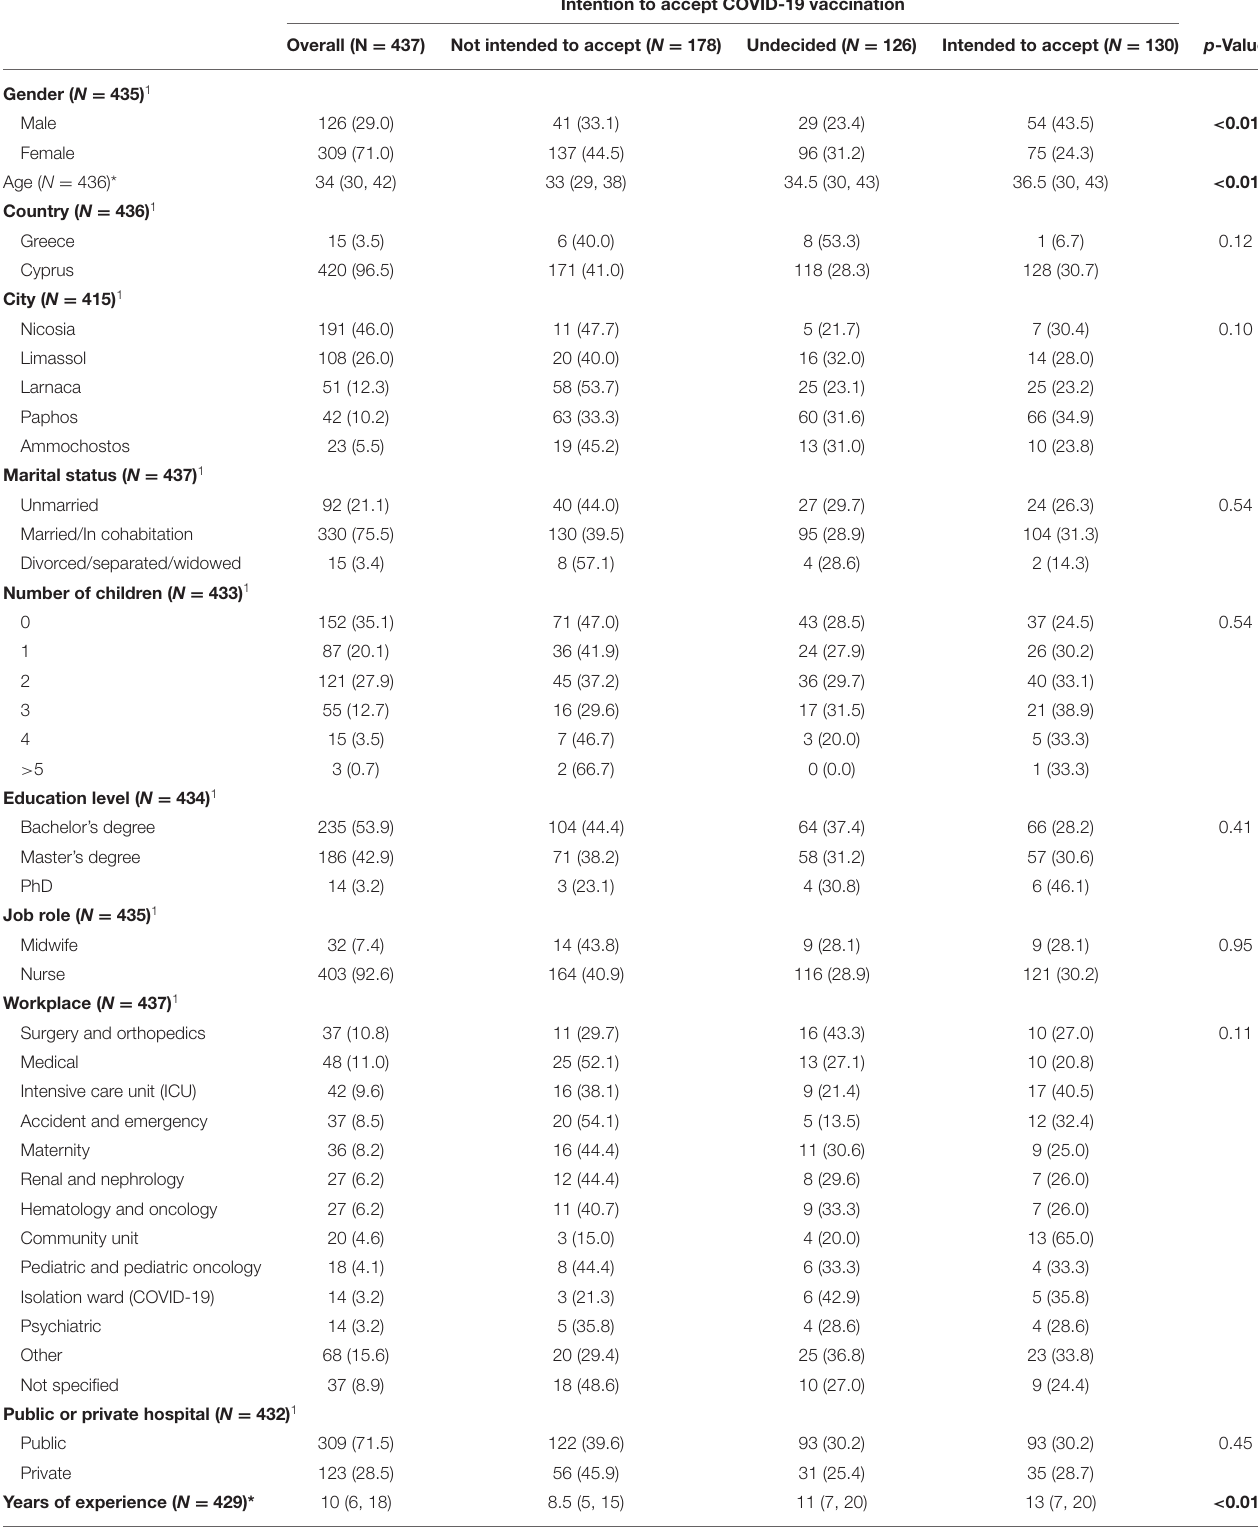
TABLE 1 | Intentions of COVID-19 vaccine acceptance by different participants